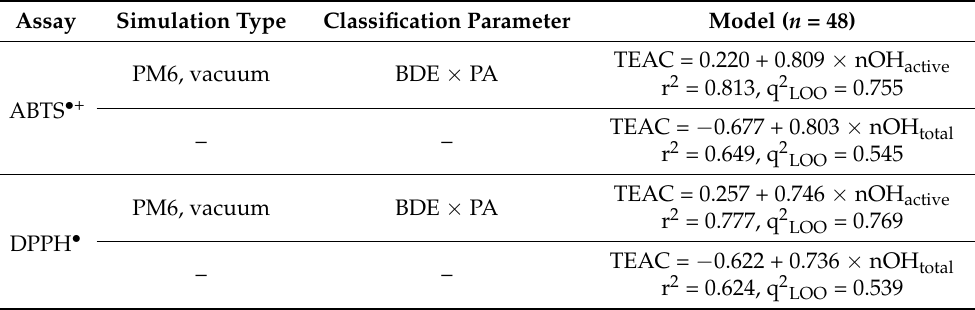
Table 3. Models with the highest internal predictive ability obtained for ABTS • + and DPPH • assays using non-chromans subgroup of compounds, compared to those obtained without OH-groups classification. For q 2 LOO calculations, all thresholds were recalculated for each LOO model.